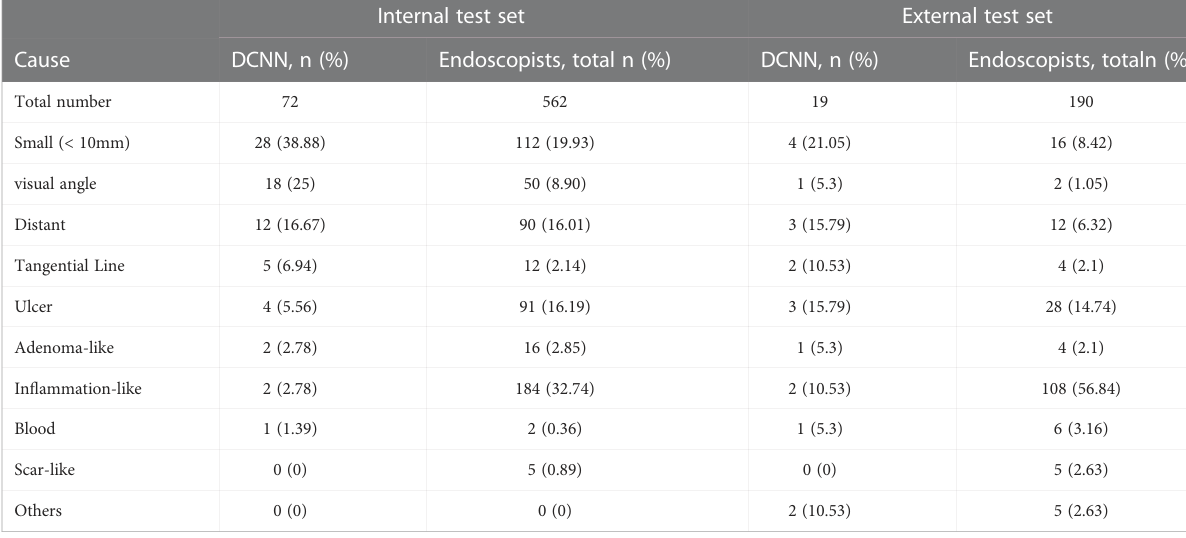
TABLE 4 Details of false negative images by DCNN model and endoscopists.